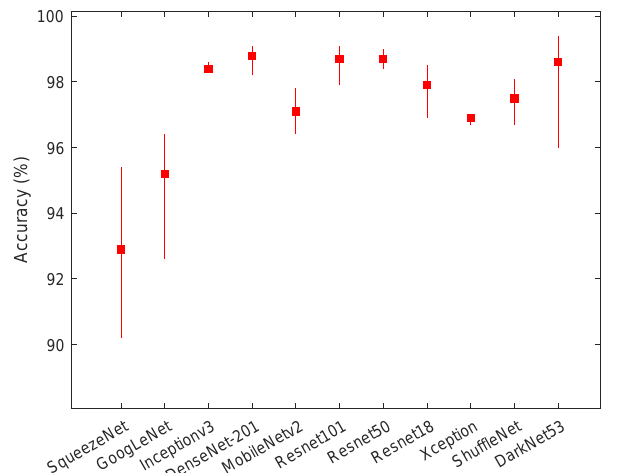
Figure 4. The mean, minimum, and maximum accuracy for all algorithms over 10 randomized runs and 50/50 data